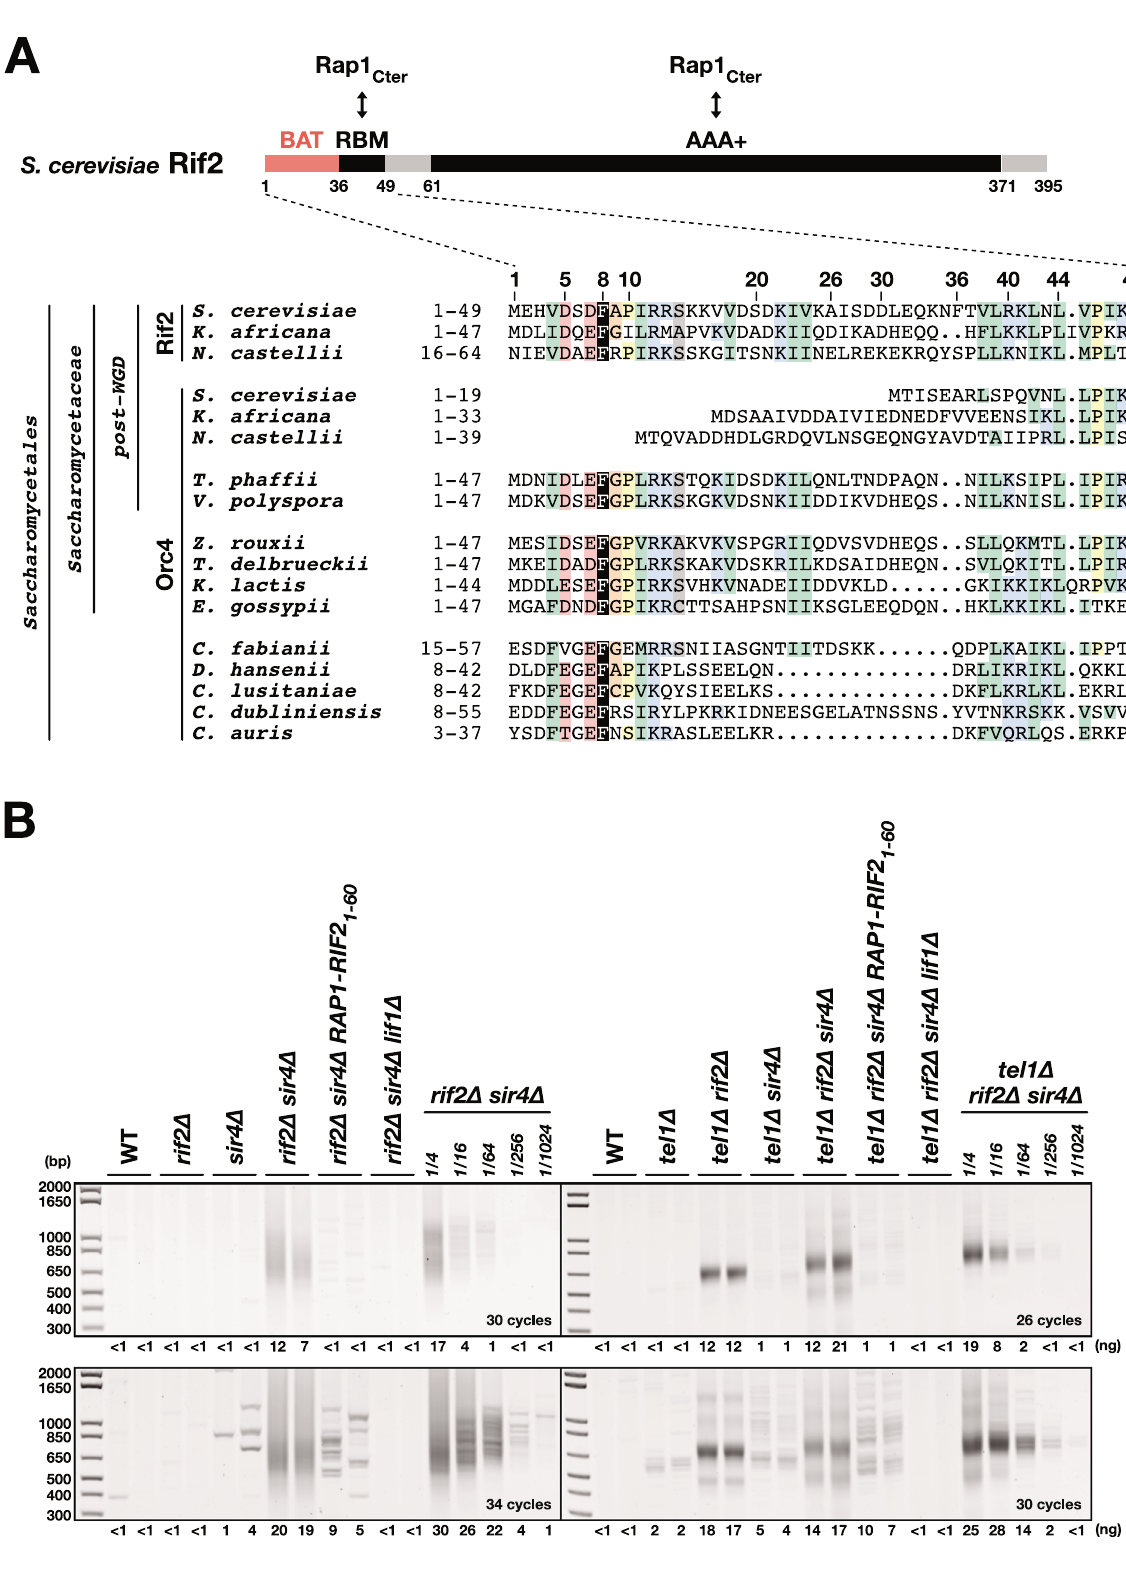
Rif2 (Fig. 2B) or Rap1 C-terminal domain (Supplementary Fig. 2C). This indicates that in these assays the BAT ability to repress NHEJ does not rely on the endogenous Rif2 protein nor on the Rap1 domain that recruits Rif2 to telomeres. The targeting of a single Gal4 DBD -Rif2 1-36 dimer inhibits NHEJ (1 Gal4 site in Fig. 2B and Supplementary Fig. 2B), showing that one or two BAT molecules are suf fi cient to